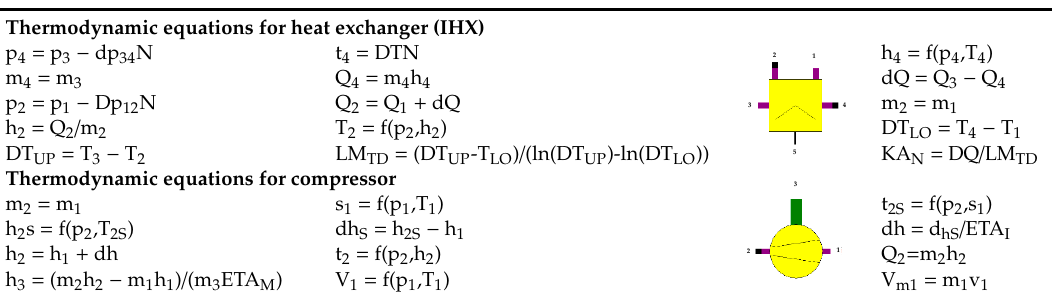
Figure 2. The HTR coupled with a gas turbine combined cycle with 3P HRSG and inter-stage steam superheated system.